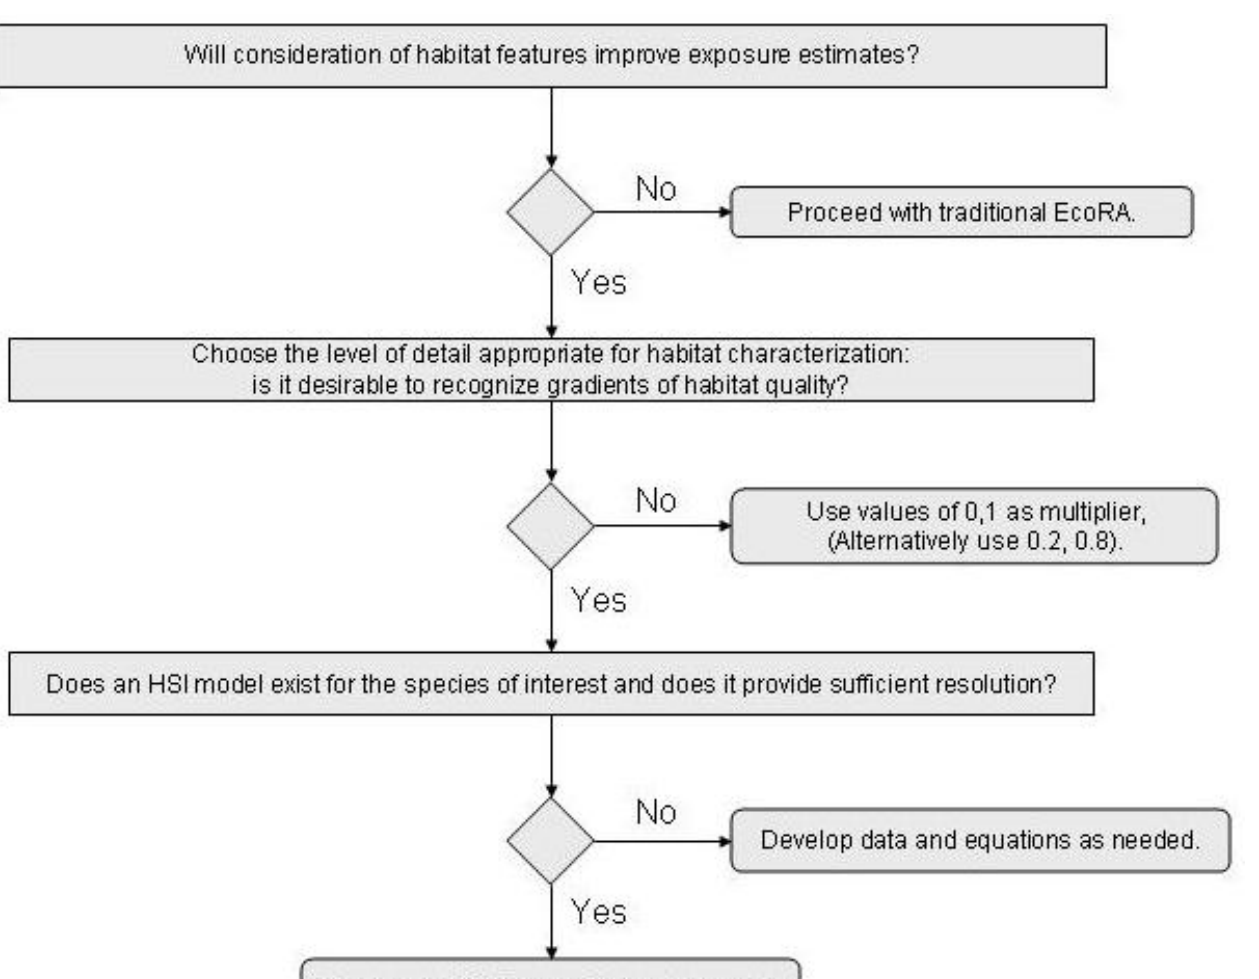
Fig. 2 . Decision tree for determining the applicability of habitat characterization and the level of sophistication warranted in assessing habitat quality. EcoRA stands for ecological risk